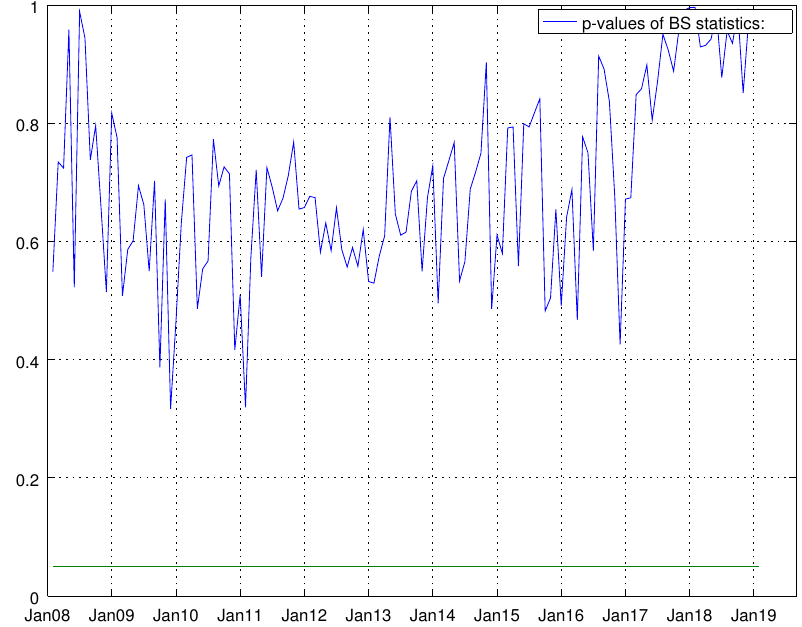
Figure 21. Graph showing the p -values of the Bowman–Shenton test for the barebone model for durable goods. The null hypothesis states that errors are normally